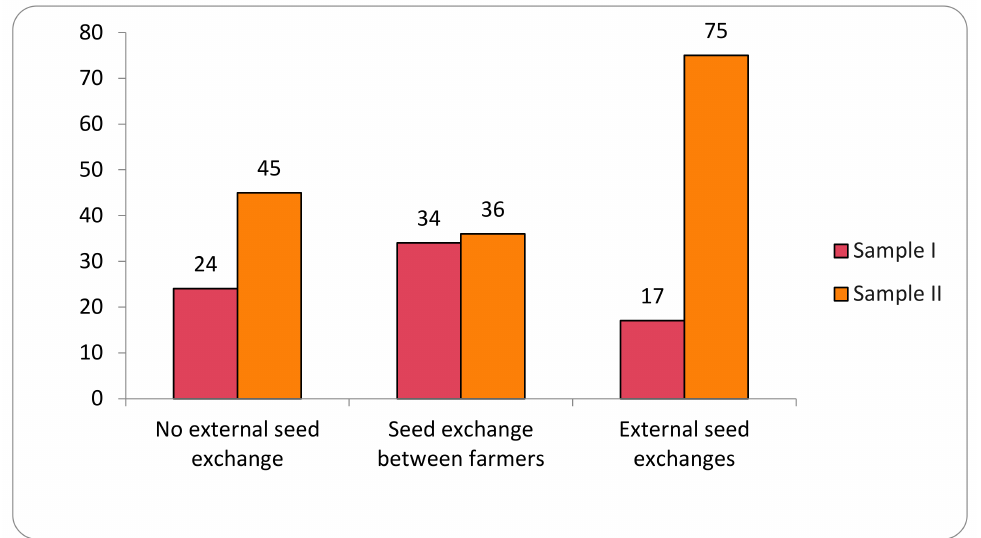
Figure 2. Transgene flow frequency into maize landraces, evaluated in two samples (Sample